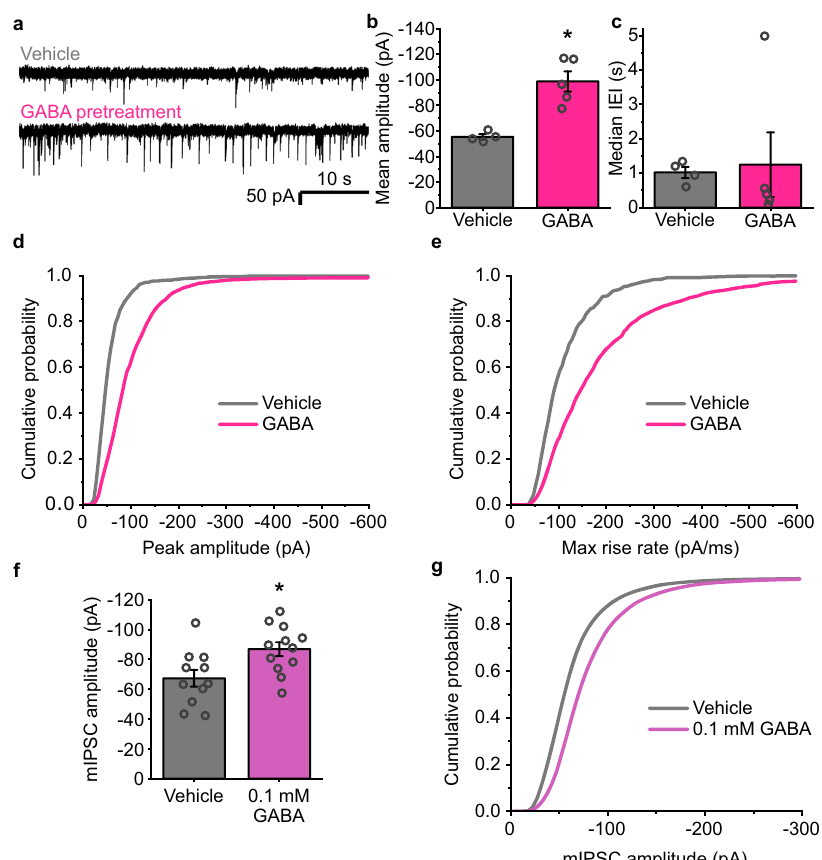
Fig. 1 GABA causes a long-term increase in inhibitory synapse ef fi cacy. a Representative spontaneous inhibitory postsynaptic currents (sIPSCs) recorded from cultured hippocampal neurons voltage-clamped at − 60 mV and pretreated with either vehicle or 1 mM GABA for 20 min ~24 h prior to recording. b Bar graph of mean amplitudes (pA) of sIPSCs displaying clean, monophasic rise phases (two-tailed t -test: t (7) = 4.75, p = 0.0021), and c median interevent intervals (IEIs) following pre-exposure to vehicle (grey) or 1 mM GABA (pink); (two-tailed t -test: t (7) = − 0.21, p = 0.83); n = 4 neurons for control, and 5 neurons for GABA). d Mean cumulative probability distribution of sIPSC amplitudes and e maximum rate of rise slopes for all sIPSCs recorded after vehicle or GABA treatment. n = 718 events from 4 neurons, and 2520 events from 5 neurons, respectively. f Bar graph of mean amplitude of mIPSCs recorded from neurons pretreated with 100 μ M GABA for 20 min prior to recording ( n = 11 neurons (Ctrl), 12 neurons ( + GABA); two-tailed t -test: t = 2.71, p = 0.013). g Cumulative probability distribution of mIPSC amplitudes. All data in the bar graphs in this fi gure and those proceeding it are (21) presented as mean values + / − SEM. Source data are provided as a Source data fi le for Fig.